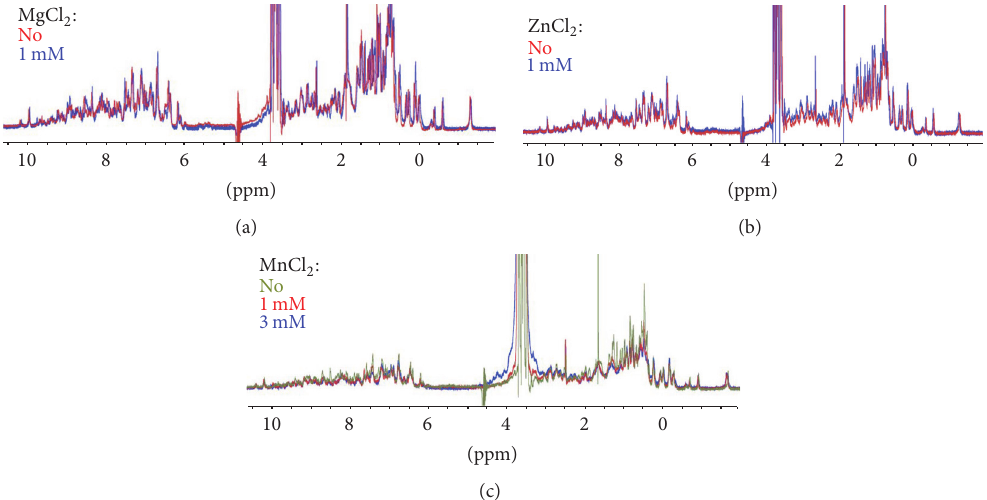
Figure 1: Regions of 1 H NMR titration (700 MHz) for binase with increasing amount of (a) MgCl 2 from 0 to 1mM, (b) ZnCl 2 from 0 to 1mM, and (c) MnCl 2 from 0 to 3 mM. Binase concentration was 1mg/mL. NMR-spectra were recorded at 298 K, pH 5.5.